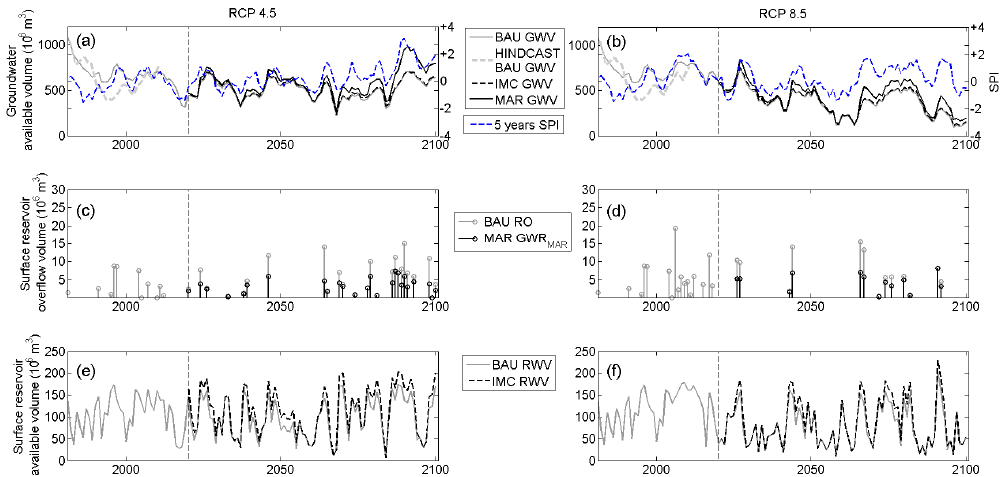
Figure 7. Panels ( a ): expected impact on the groundwater available volume of adaptation scenarios starting in 2020 under RCP 4.5. The associated 60 month (5 years) SPI is reported on the right axes. Panel ( b ): expected impact on the groundwater available volume of adaptation scenarios starting in 2020 under RCP 8.5. The associated 60 month (5 years) SPI is reported on the right axes. Panels ( c ) and associated total overflow from the surface reservoir, and actual volume infiltrated for the managed aquifer recharge (MAR) under RCP 4.5. Panel ( d ): associated total overflow from the surface reservoir, and actual volume infiltrated for the managed aquifer recharge (MAR) under RCP 8.5. Panel ( e ): surface reservoir available volume under RCP 4.5. Panel ( f ): surface reservoir available volume under RCP 8.5. The vertical dash lines indicate the starting year of adaptation scenarios. The vertical dot lines indicate the beginning of RCP 4.5 (panels a, c and e) and RCP 8.5 (panels b, d and f) emission scenarios.